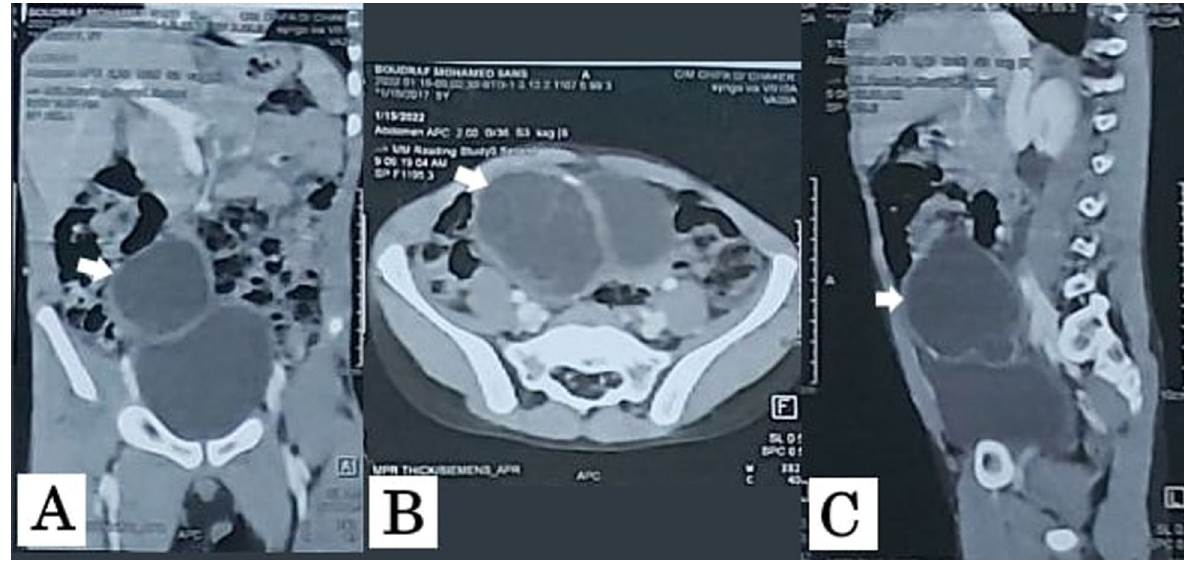
Fig. 2 Abdominal computed tomography A Longitudinal section depicts the cyst position and adherence to the bladder. B Cross-sectional demonstrates the cyst pushing the bladder anterolaterally. C Sagittal sectional shows the cyst position relative to the digestive structures